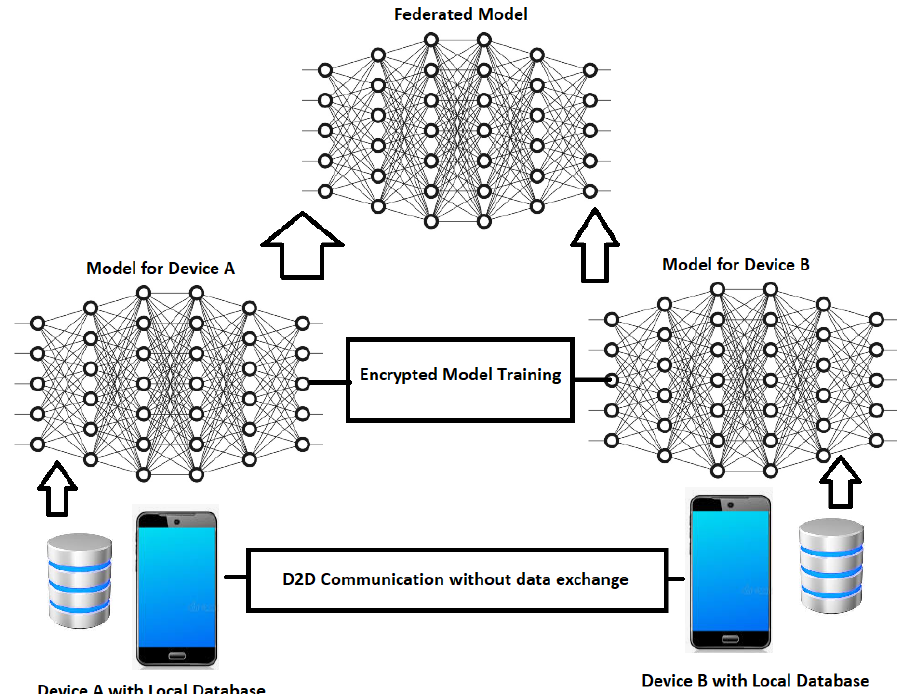
Figure 4. D2D communication without data exchange in FL.